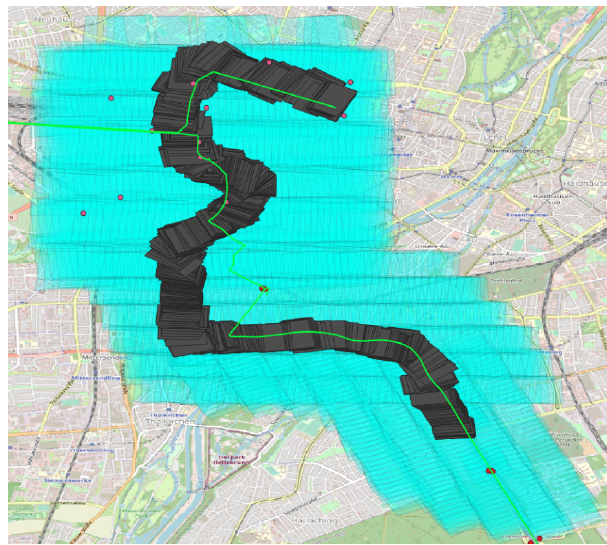
Figure 9. Footprints of the urban image sequence (black) supplemented with an image block acquired in regular strips (cyan), planned route (green) and ground control and check points (red dots).